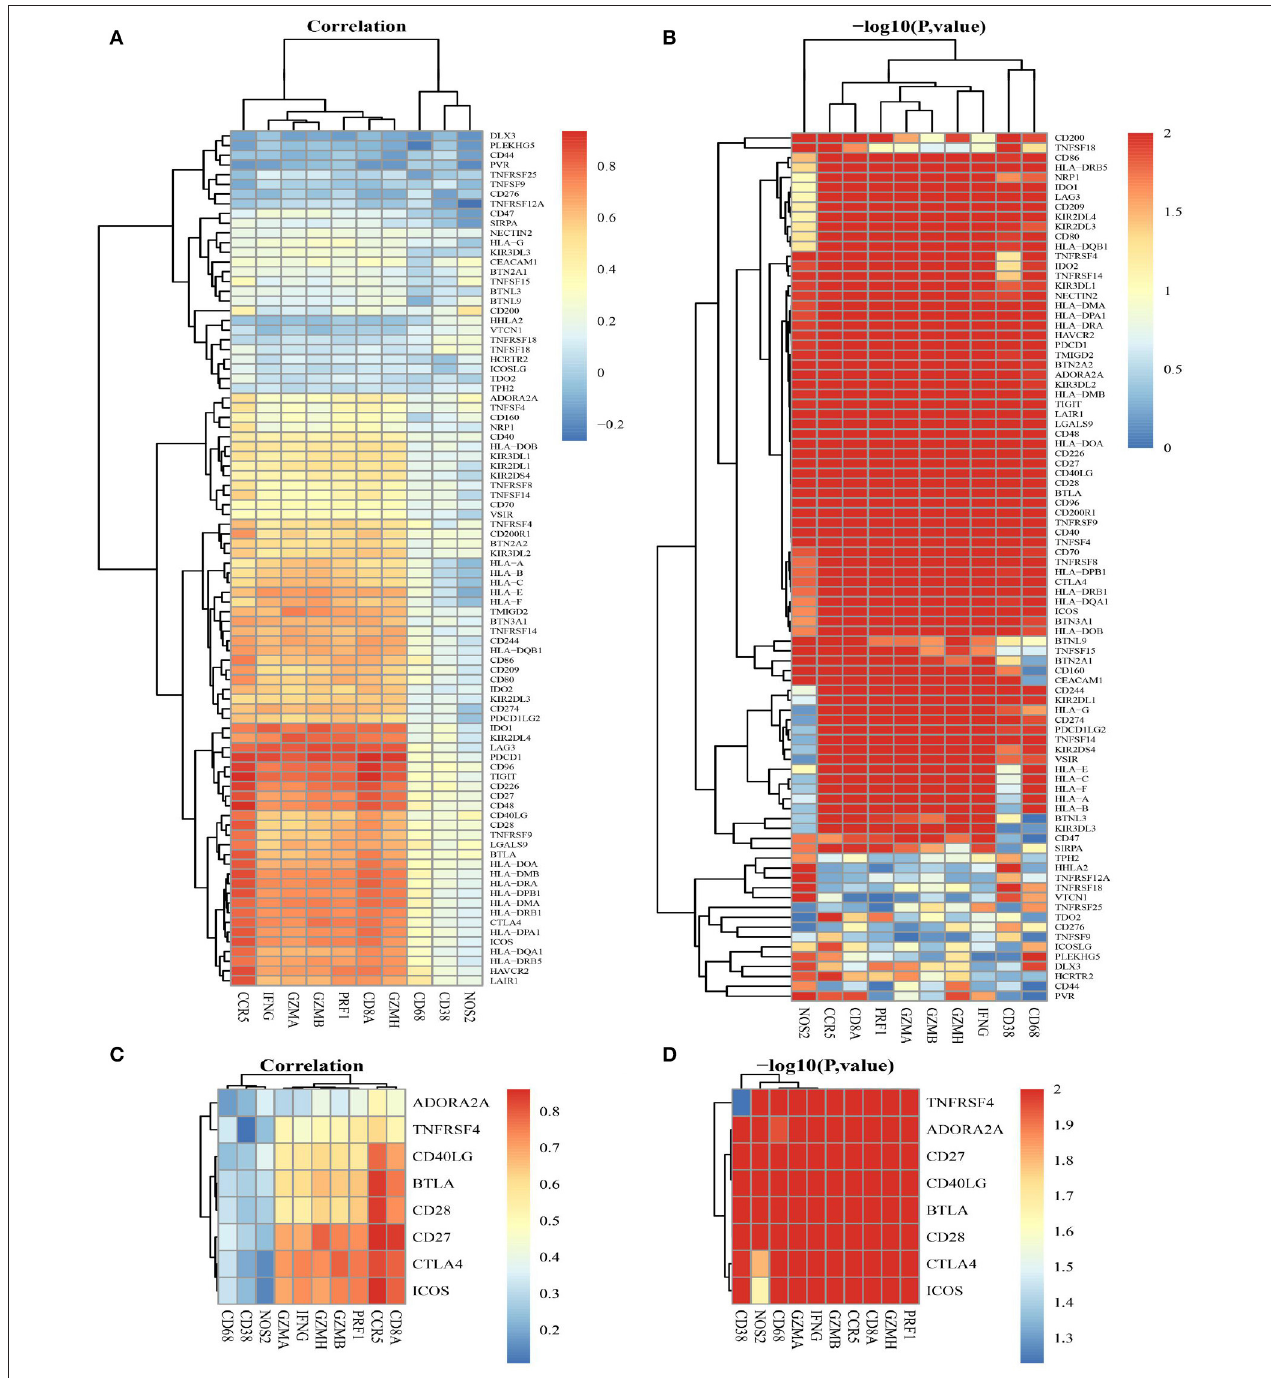
FIGURE 7 | The correlation between adaptive immune resistance pathway genes and ICGs. (A) A heat map shows the correlation coefficients between 10 adaptive immune resistance pathway genes and 88 ICGs. (B) A heat map shows –log 10 p for the correlation between adaptive immune resistance pathway genes and 88 ICGs. (C) A heat map shows the correlation coefficients between adaptive immune resistance pathway genes and CD274-related ICGs (ADORA2A, TNFRSF4, CD40LG, BTLA, CD28, CD27, CTLA4, and ICOS). (D) A heat map shows –log 10 p for the correlation between adaptive immune resistance pathway genes and CD274-related ICGs (ADORA2A, TNFRSF4, CD40LG, BTLA, CD28, CD27, CTLA4, and ICOS).